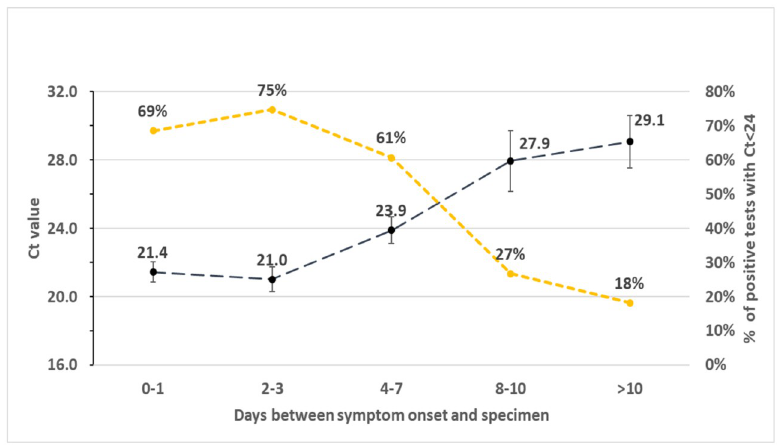
Fig 7. Mean CT and % CT < 24 by days between symptom onset and